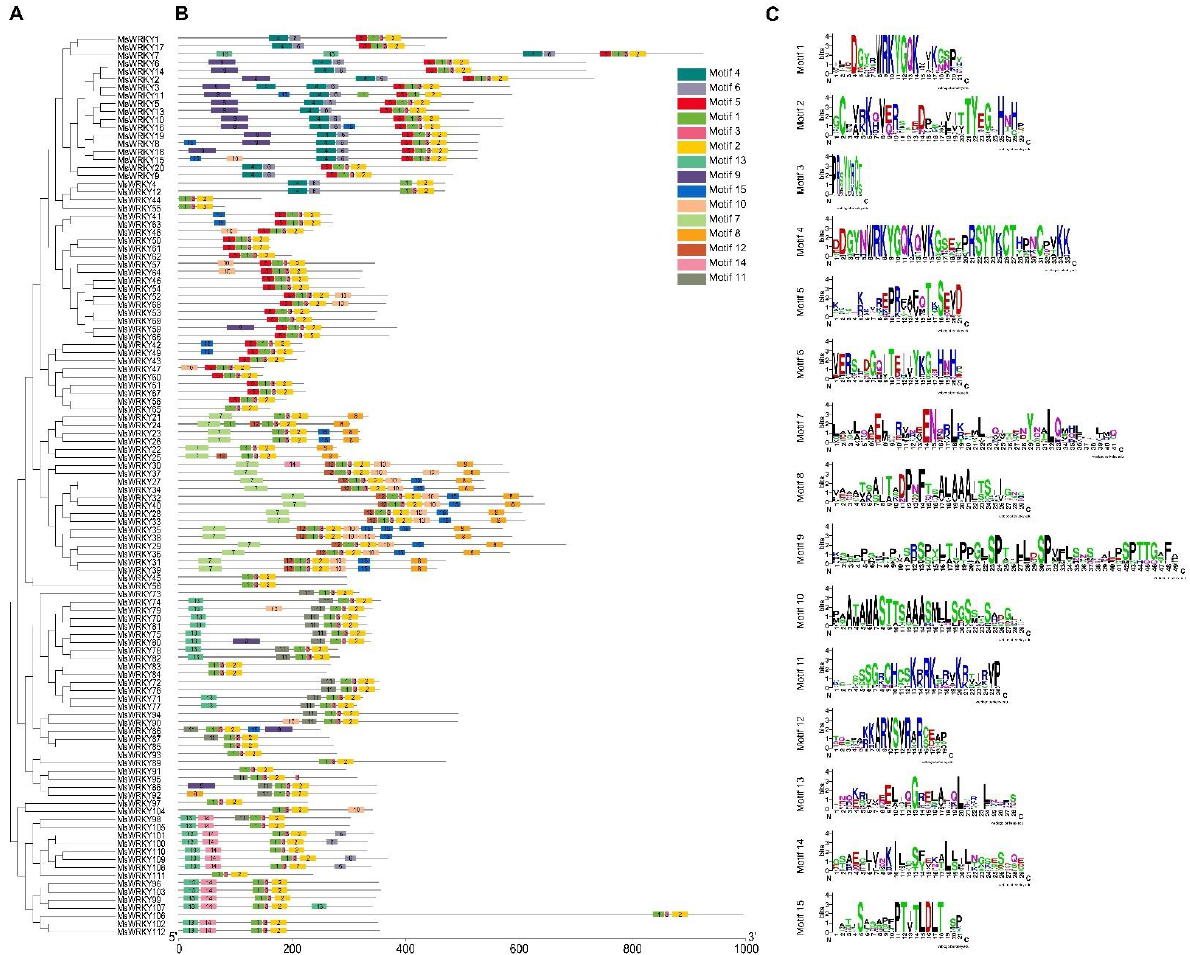
Figure 2. The conserved motif arrangements of MsWRKY proteins. ( A ) The phylogenetic tree of MsWRKY predicted proteins constructed by MAGA 7.0. ( B ) The motif compositions of WRKY proteins. The motifs 1–15 were displayed in different colors. ( C ) The sequence information of each motif.